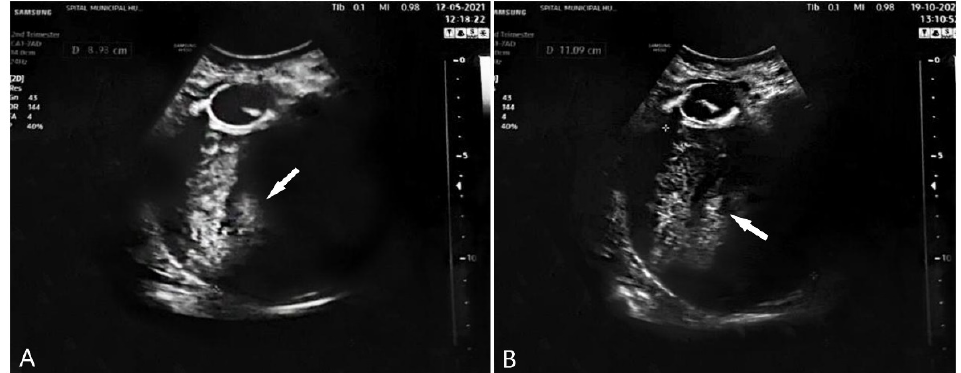
Figure 4. ( A ) Ultrasound examination of atypical polypoid adenomioma (APA); ( B ) ultrasound examination of carcinosarcoma.(Indicated by arrow)